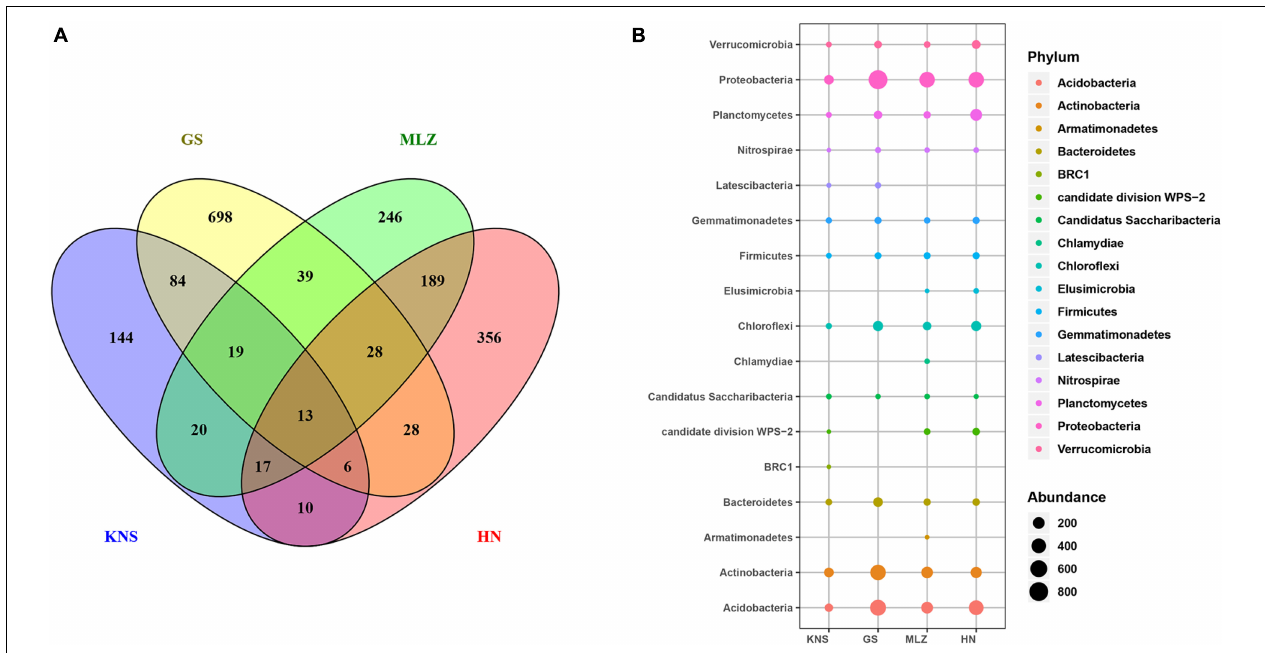
FIGURE 2 | Geographical distribution of soil bacteria in four forest types (KNS = Kanas, GS = Gansu, MLZ = Mulinzi, HN = Hainan). (A) A Venn diagram of soil bacteria in four forest types, illustrating the shared and exclusive number of OTUs. (B) The composition of soil bacterial communities in four forest types at the phylum